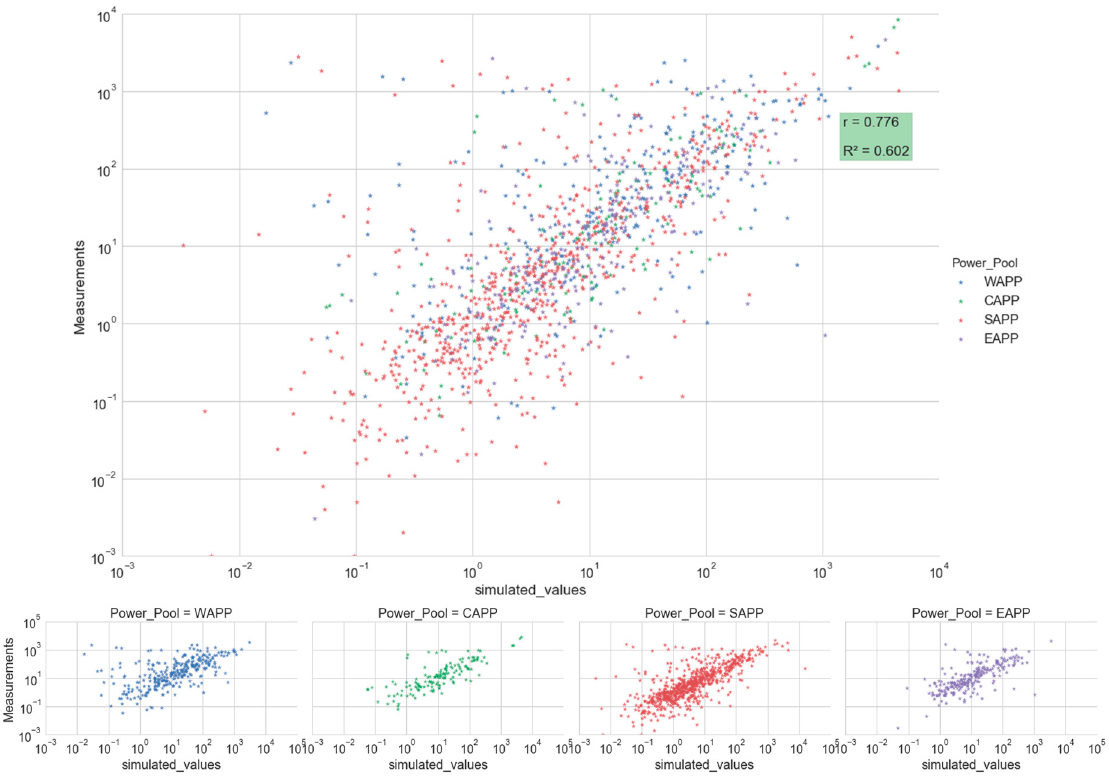
Figure 4. Observed (GRDC measurements) vs. simulated (DEM–GSCD) scatter plots; aggregated (above) and by power pool (below); values are in m 3 /s.